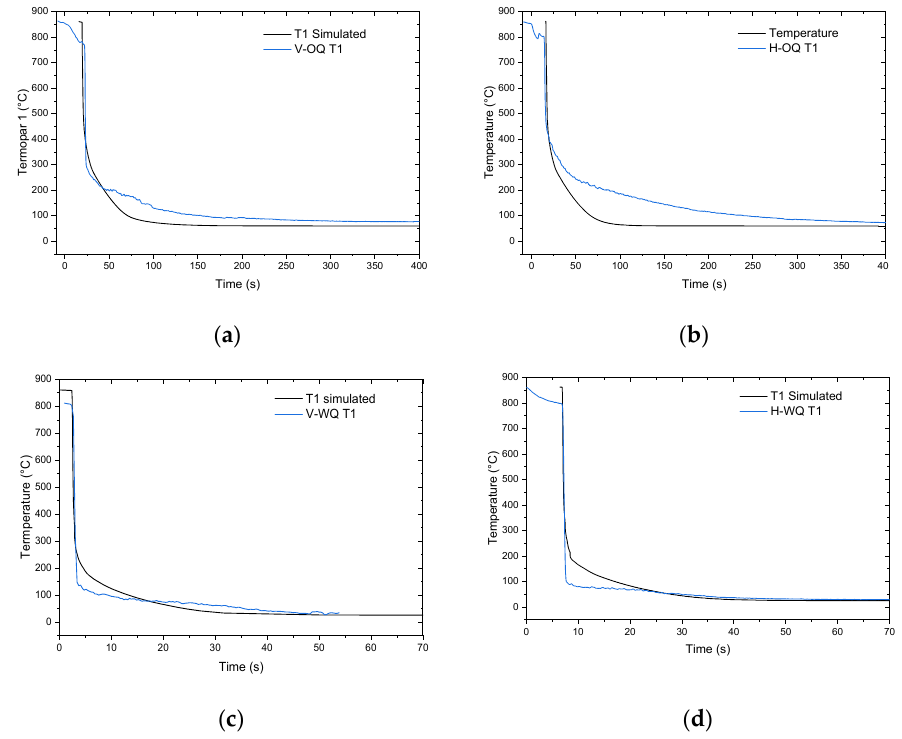
Figure 7. Comparison between simulated cooling curves and those measured with thermocouples in different quenching media and immersion modes: ( a ) V-OQ; ( b ) H-OQ; ( c ) V-WQ; and ( d ) H-WQ.